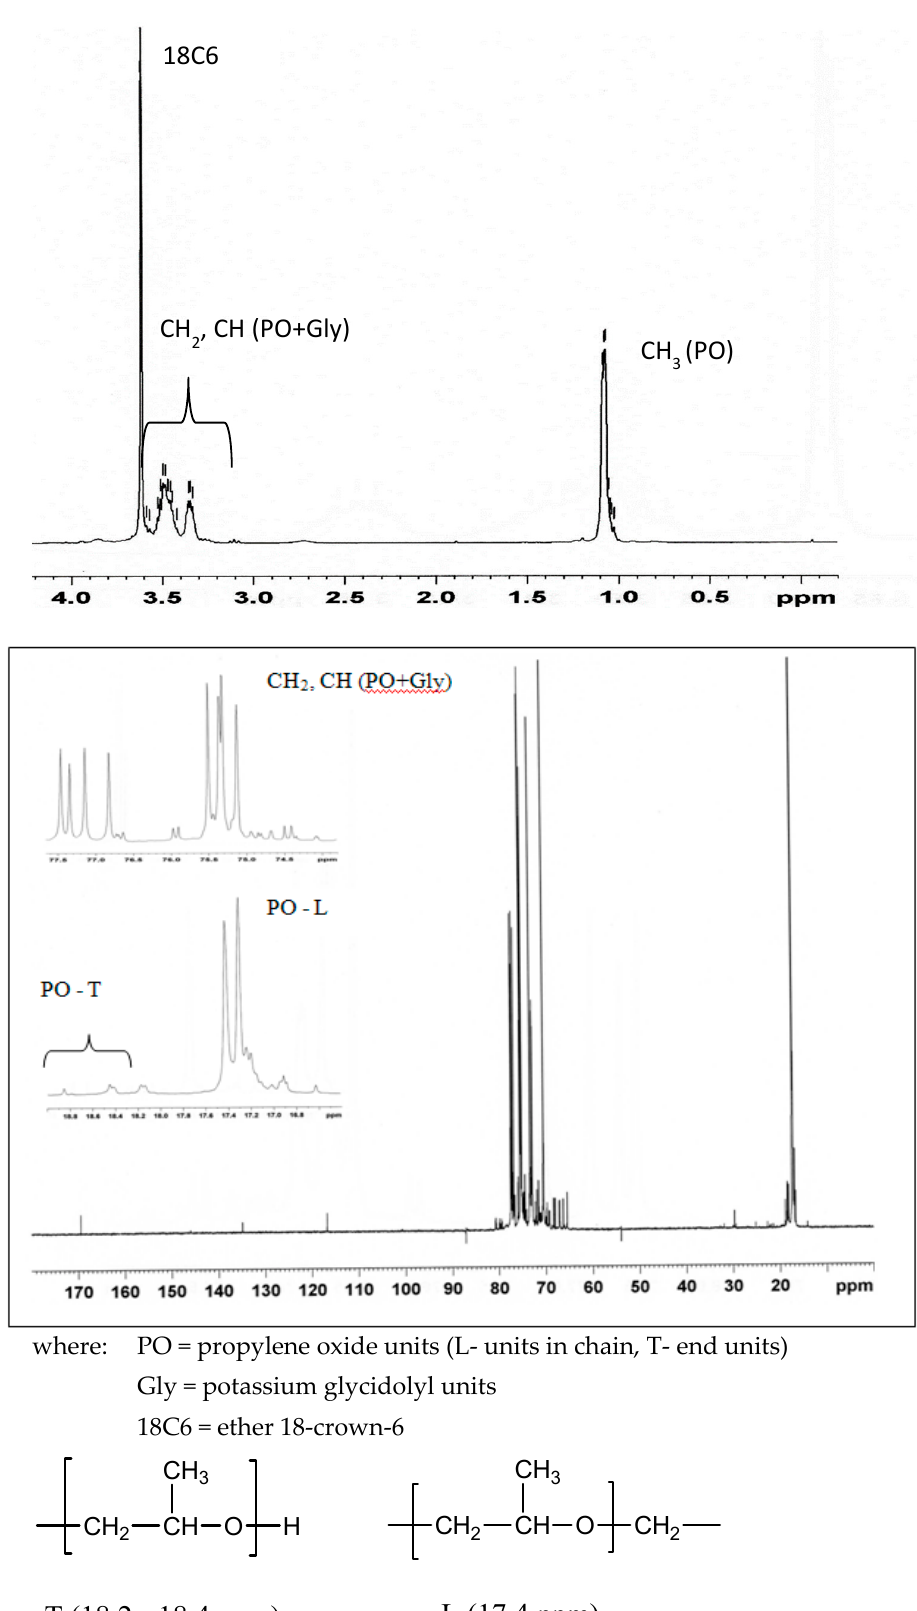
where: PO = propylene oxide units (L- units in chain, T- end units)